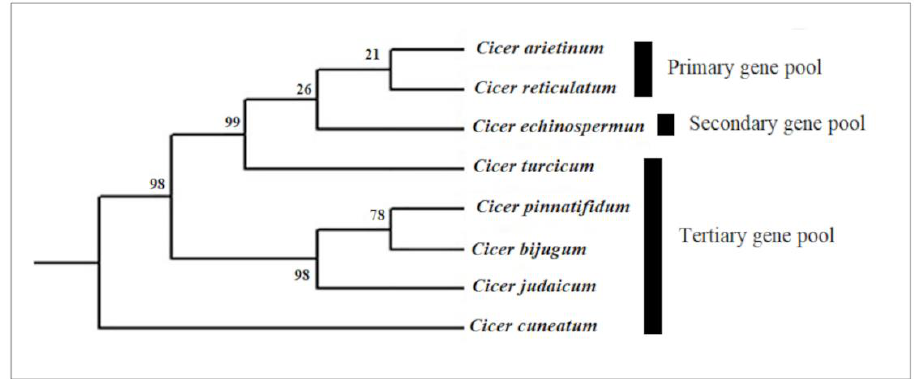
Figure 2. Phylogenetic tree from the maximum parsimony analysis based on ITS region in annual Cicer species belonging to different gene pools, adapted from Toker et al. [15].